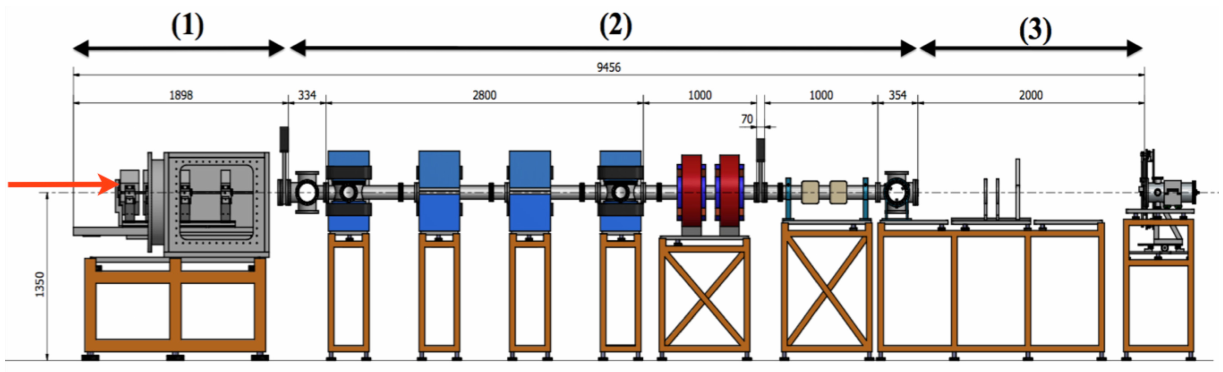
Figure 1. Scheme of the ELIMED beam line showing the three different sections: ( 1 ) ion beam collection and diagnostics; ( 2 ) in-vacuum ion beam selection, transport and diagnostics; ( 3 ) dosimetry and sample irradiation. Distances are in